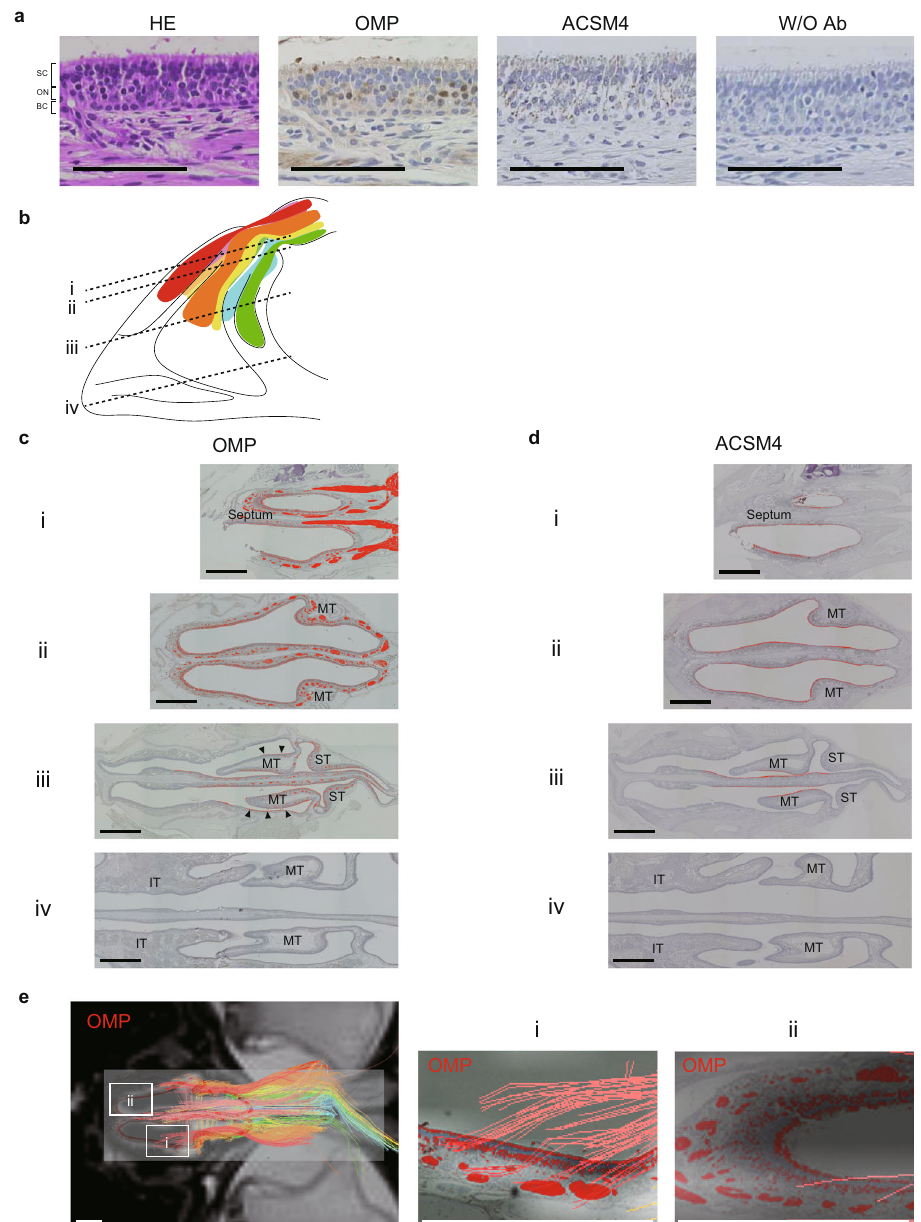
Fig. 6 Histological sections of marmoset tissue immunostained for olfactory marker protein (OMP) or acyl-coenzyme A synthetase medium chain family member-4 (ACSM4). a Histological sections of the olfactory epithelium of the marmoset. The mucosa consists of an upper layer containing mainly supporting cells (SC), a middle layer of olfactory nerve cells (ON) that display chemoreceptors on the mucosal surface, and a lower layer of basal cells (BC). Nerve bundles consisting of multiple nerve cell axons can be seen in the submucosa. Scale bars: 100 μ m. ACSM4, acyl-coenzyme A synthetase medium chain family member-4; HE, hematoxylin-eosin; OMP, olfactory marker protein; W/O Ab, without antibody. b Tissue sections were obtained at four levels (i, ii, iii and iv) for further analysis. c Histological sections of the marmoset nasal cavity immunostained for OMP. The OMP-positive regions are shown in red. OMP-positive regions were seen in both the mucosal layer and as nerve bundles in the submucosal layer. Scale bars: 1 mm. IT inferior turbinate, MT middle turbinate, OMP olfactory marker protein, ST superior turbinate. d Histological sections of the marmoset nasal cavity immunostained for ACSM4. The ACSM4-positive regions are highlighted in red. The ACSM4-positive regions were limited to the mucosal layer and were less extensive than the OMP-positive regions. Scale bars: 1 mm. IT inferior turbinate, MT middle turbinate, OMP olfactory marker protein, ST superior turbinate. e Overlaid magnetic resonance images, tractography images and OMP-stained images. Tractography detected the thicker nerve bundles in the submucosal layer. Scale bars: 1